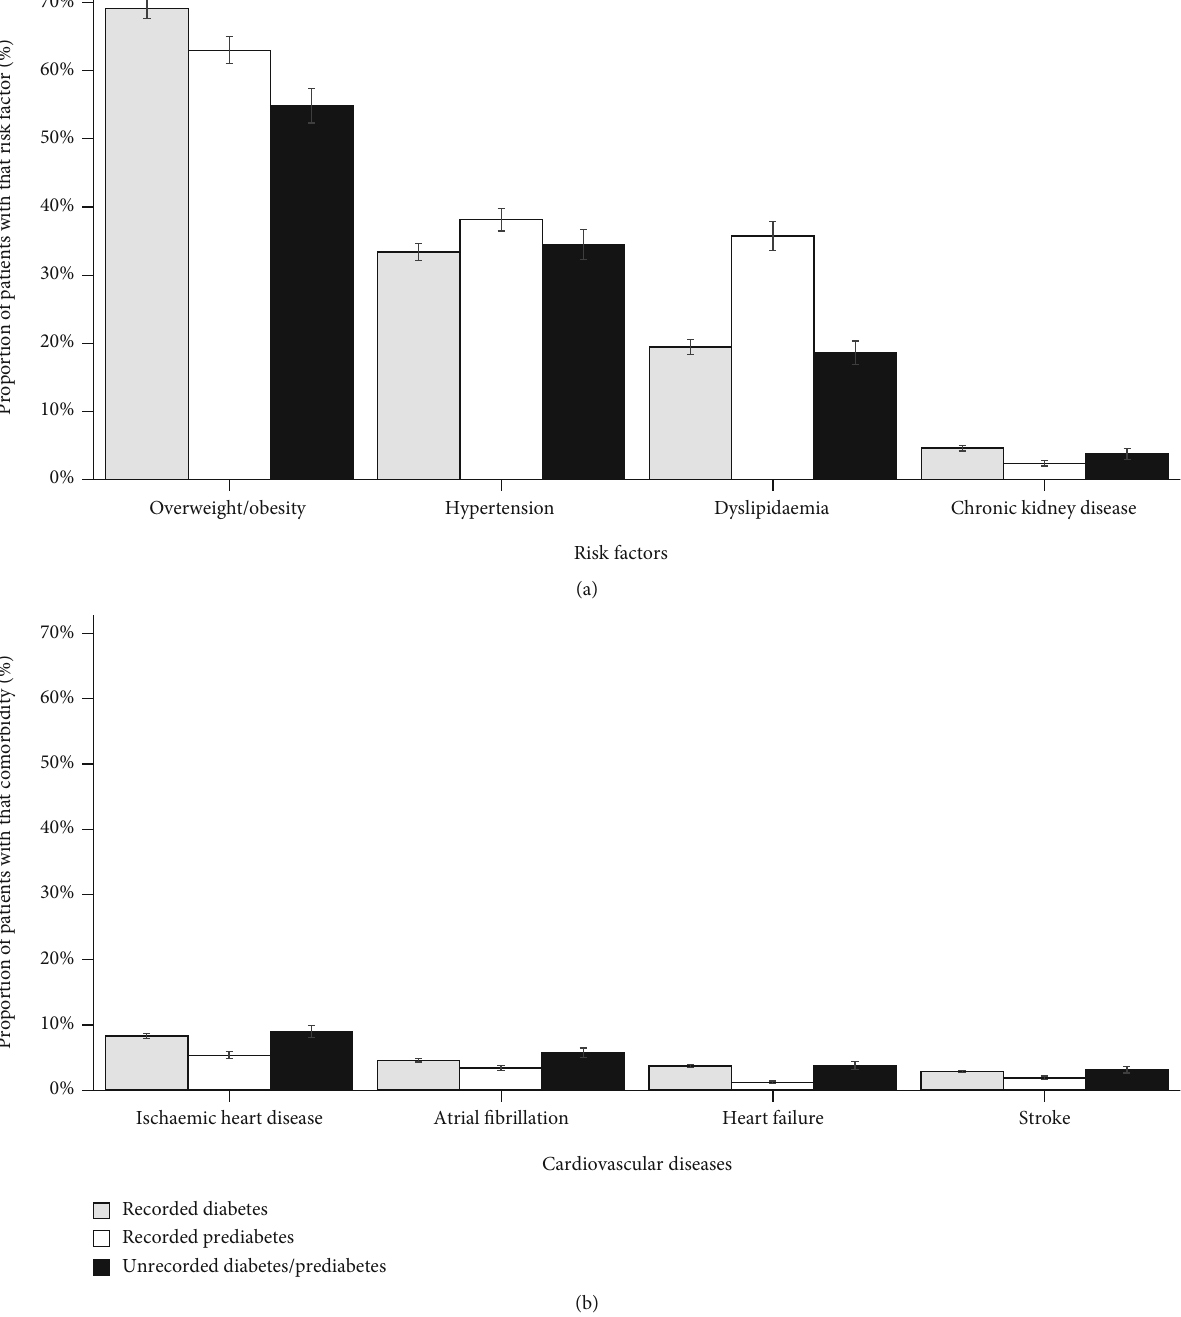
Figure 2: Prevalence of diabetes-related comorbidities ((a) risk factors for cardiovascular disease; (b) cardiovascular disease) among regular patients (aged 18+ years) with recorded diabetes, recorded prediabetes, and unrecorded diabetes/prediabetes (Australia,